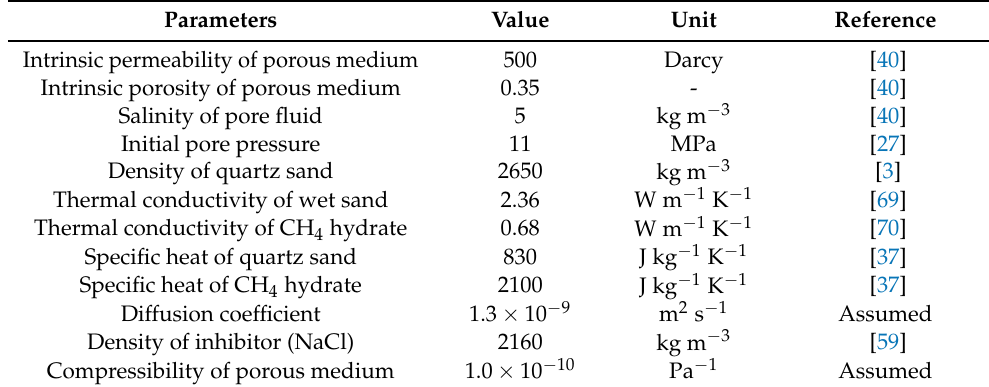
Table 3. Thermophysical properties of the porous medium and related components in LARS. Parameters Value Unit Reference Intrinsic permeability of porous medium 500 Darcy Intrinsic porosity of porous